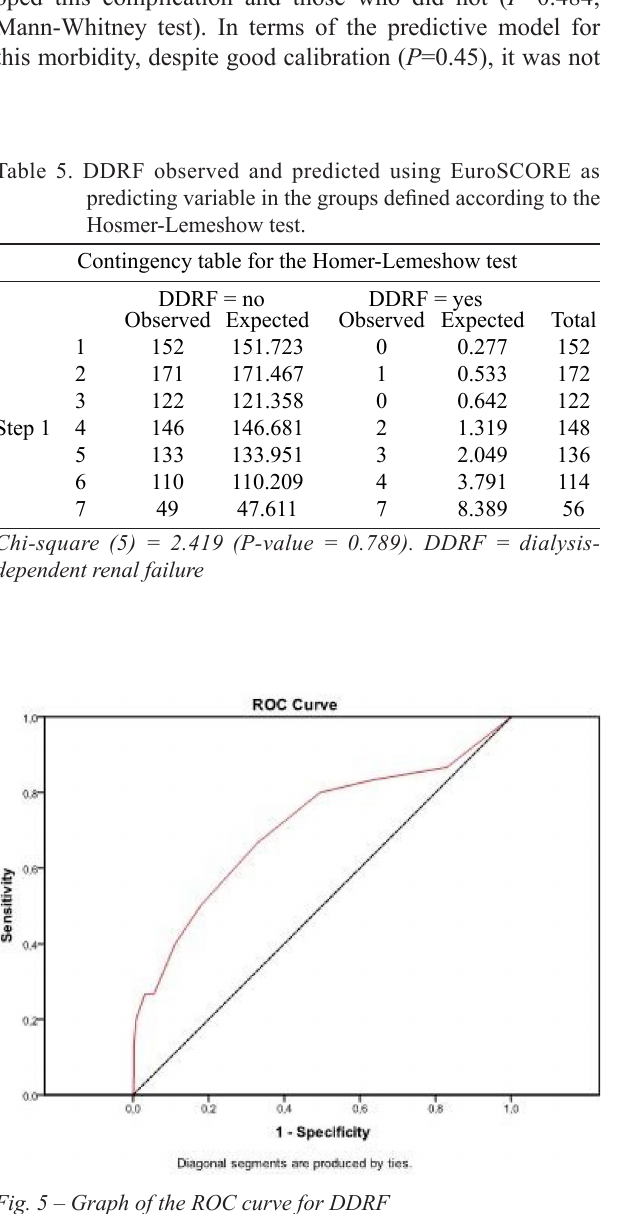
Fig. 5 – Graph of the ROC curve for DDRF